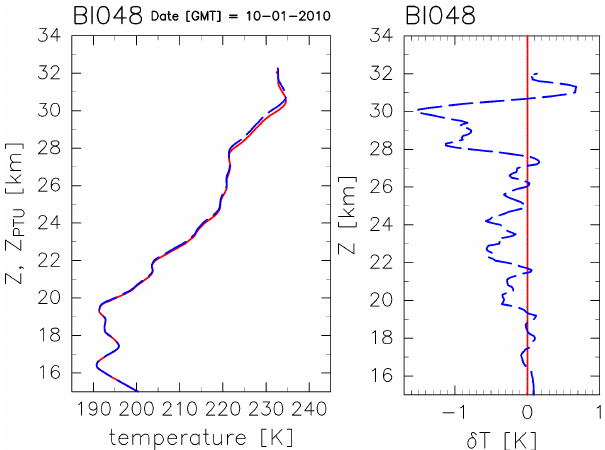
Figure 3. (Left) Example of temperature profiles based on Z PTU ( T (Z PTU ) ≡ T PTU (Z) ; blue dashed line) and Z ( T (Z) ; red line) measured over Biak on 10 January 2010. (Right) Difference be- tween the two temperature profiles in the left panel, defined as T PTU (Z) minus T (Z) (blue dashed line).